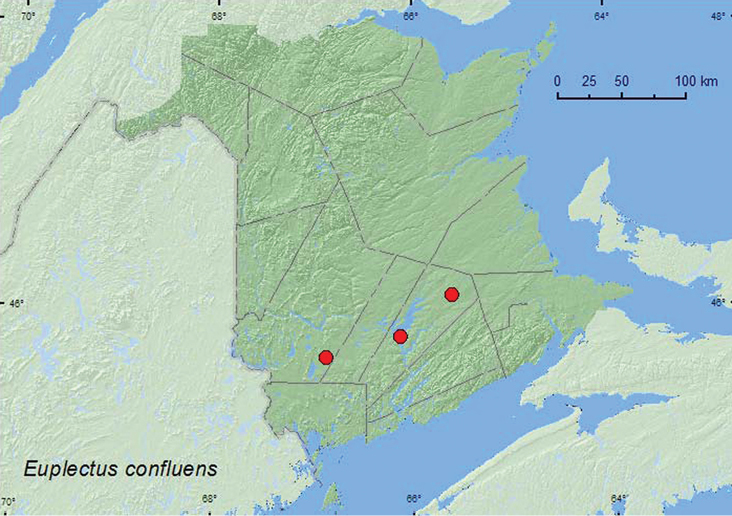
Collection localities in New Brunswick, Canada of Euplectus confluens.